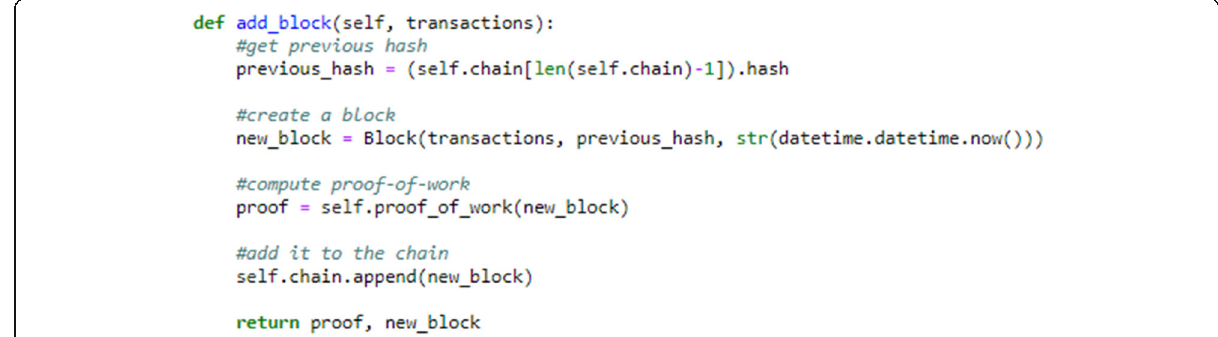
Fig. 7 Blockchain class method for adding student ’ s blocks to the